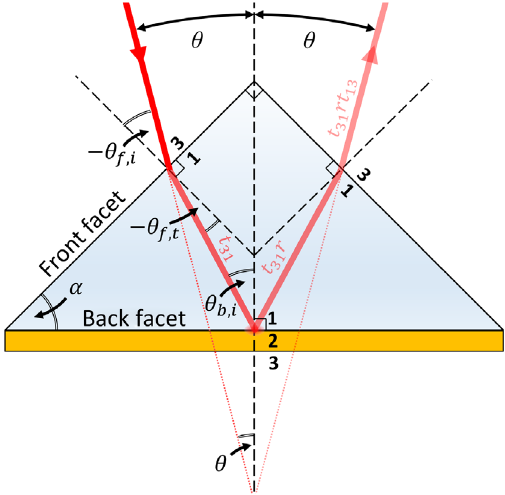
FIG. 6. Path traveled by light in the coupling prism. The reflected beam (red) undergoes the primary beam path in the glass prism, consisting of transmission through the first front facet ( t 31 ), reflection from the back facet ( r ), and transmission through the second front facet ( t 13 ). The incidence ( θ i ) and transmission ( θ t ) angles in each passage are taken as positive if the beam propagation direction is counterclockwise to the facet normal (dashed black lines) and negative